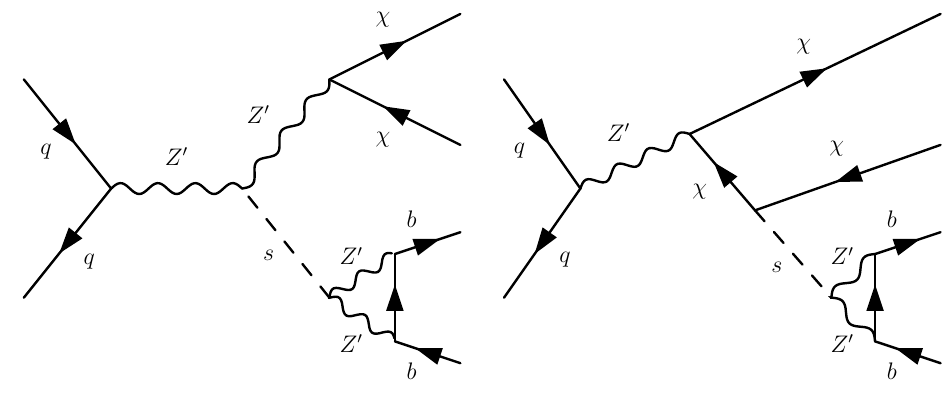
Figure 3 . Examples of typical processes producing a dark Higgs boson together with a pair of DM particles. The dark Higgs boson subsequently undergoes loop-induced decays into bottom